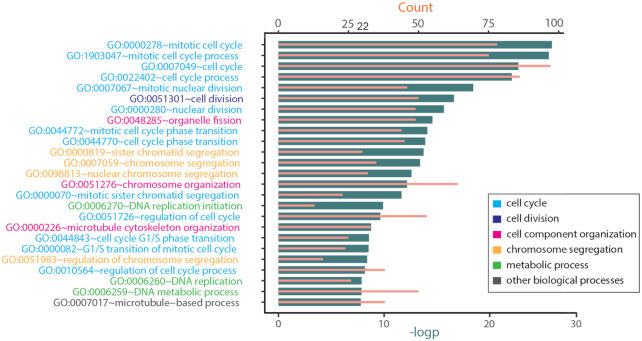
GO enrichment analysis of important genes in predicting MM progression. The top 25 significant GO biological processes were enriched from 342 key genes related to MM progression. In the list, color indicates biological process class. Most biological processes are related to the cell cycle. In the bar graph, the dark bars are the negative logarithmic transformation of the P-value, and the light bars are the counts of genes.